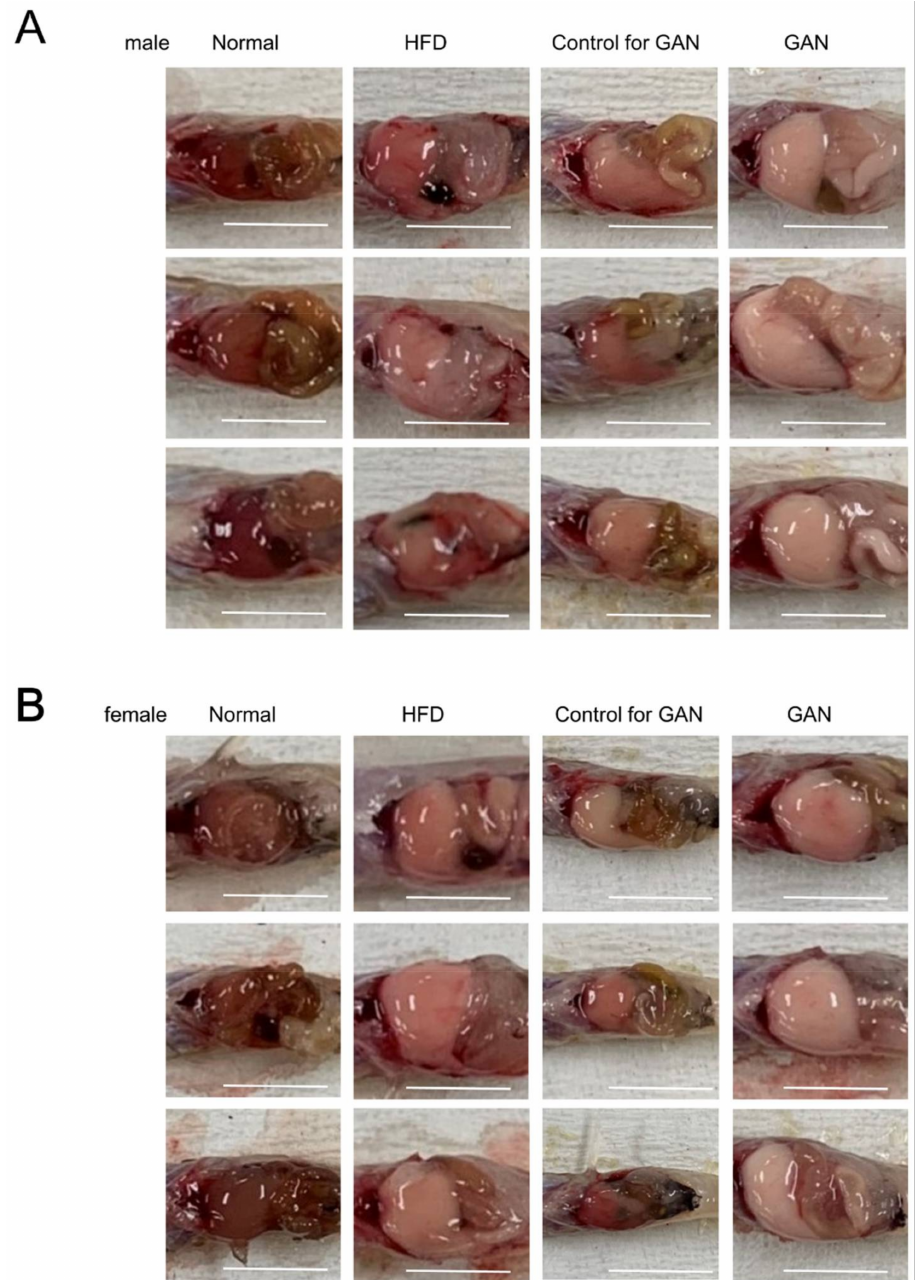
Figure 3. Liver changes in medaka three months after the start of the experiment. ( A ) Representative liver macroscopic findings (male) after administering each diet for three months. ( B ) Representative liver macroscopic findings (female) after administering each diet for three months. The scale bar represents 5